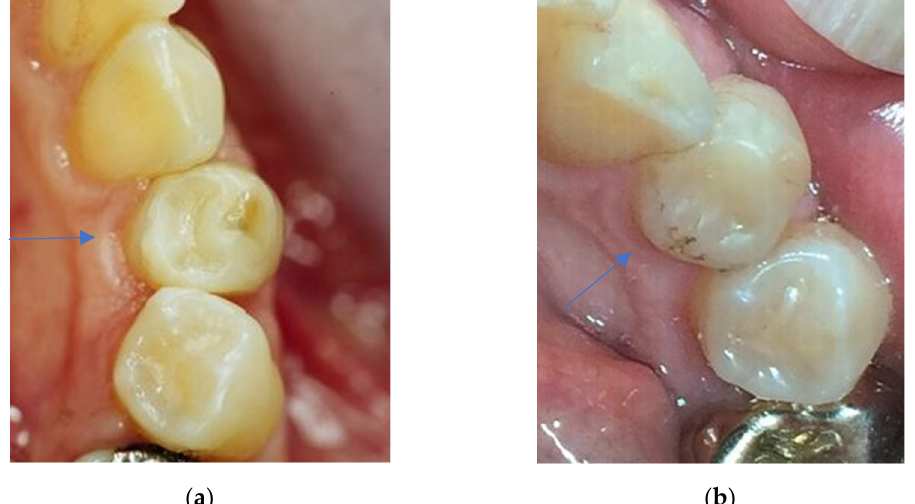
Figure 5. ( a ) Clinical view of a Herculite XRV restoration at first examination (34 modvl). Six out of seven criteria scored clinically excellent/very good (grade 1) results. The approximal anatomical form was the only criterion with a clinically unsatisfactory (grade 4) result. ( b ) Clinical view of the Herculite XRV restoration shown in Figure 5a after 24 years in situ. All criteria scored clearly higher grades in the second examination. Aesthetic anatomical form and retention received the highest grades (grade 4 = clinically unsatisfactory). Only the criteria approximal anatomical form scored lower grades in the second examination (grade 2 = clinically good) than in the first examination, due to the new prosthetic restoration on the adjacent tooth, which led to a new, more appropriate approximal contact point.